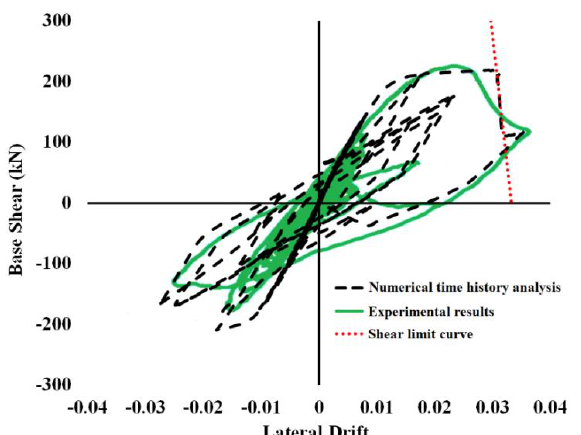
Fig. 3. The comparison of numerical and experimental models via Non-linear time history